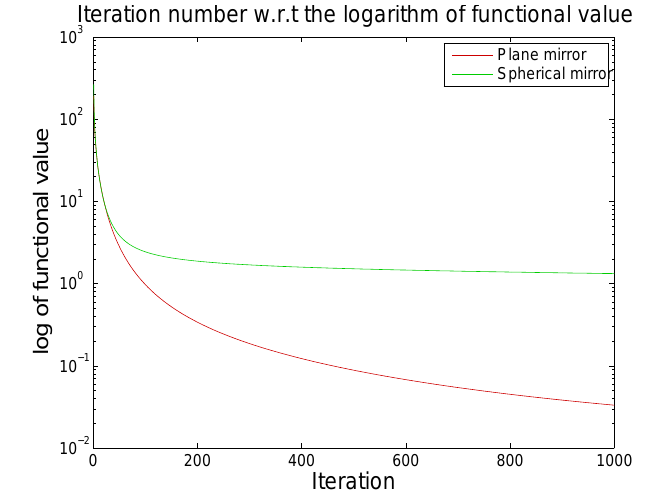
Figure 5. Logarithm of functional value during iteration for a mea- sured plane reference mirror (lower curve) and for the spherical ref- erence mirror (upper curve).